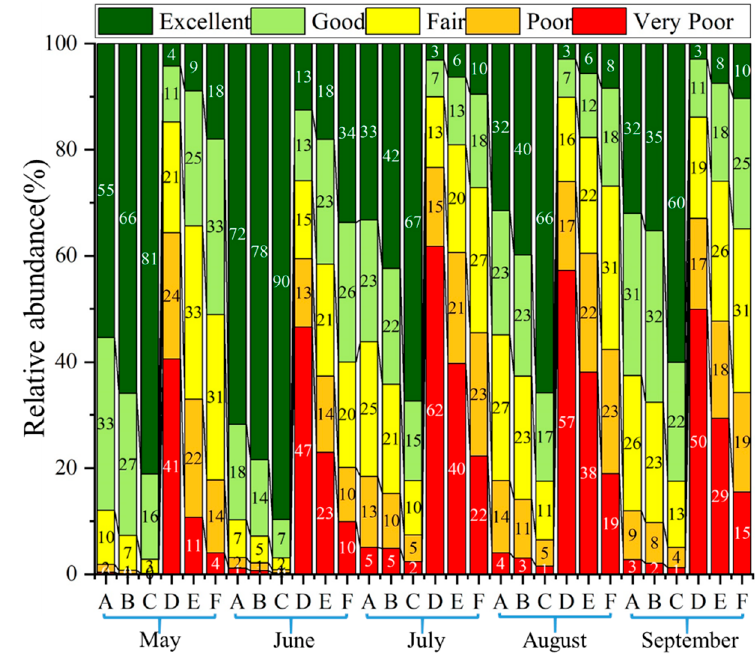
Figure 8. Relative abundance of vegetation growth, namely, the percentage of NDVI difference at different levels in different inundation frequency transfer regions.